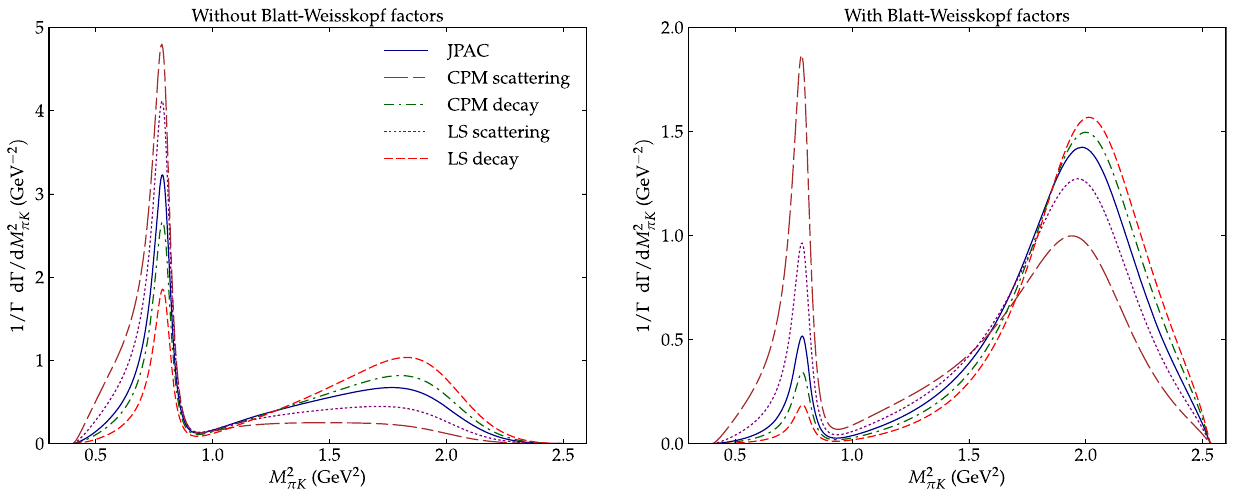
Fig. 3 Comparison of the lineshape of K ∗ ( 892 ) and K ∗ ( 1410 ) in the π K -invariant mass distribution, constructed with the different formalisms. In the left panel we show the result with no barrier factors. In the right panel, we include the customary Blatt-Weisskopf